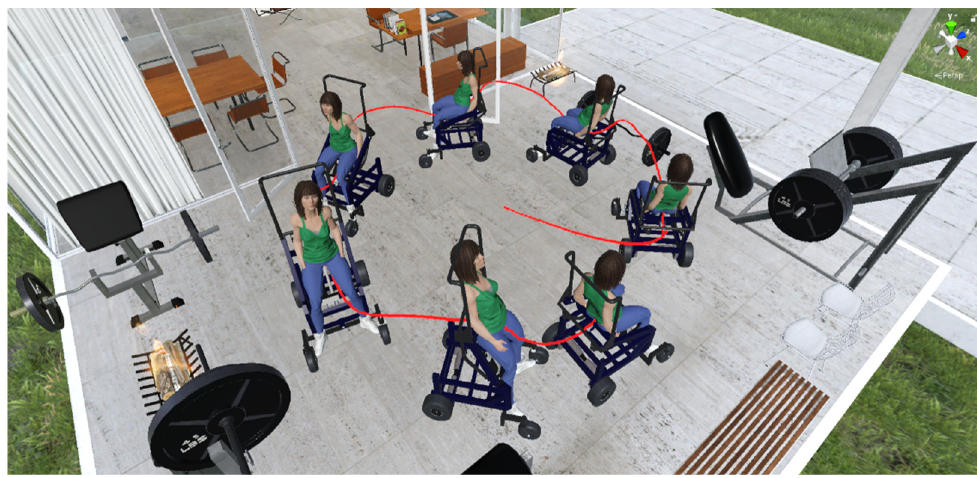
Figure 22. Virtual stroboscopic movement of the robot–human system.